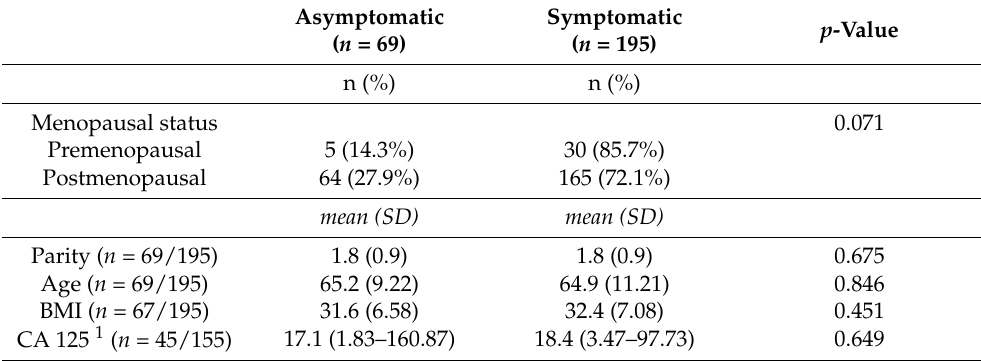
Table 1. Patients’ clinical characteristics.